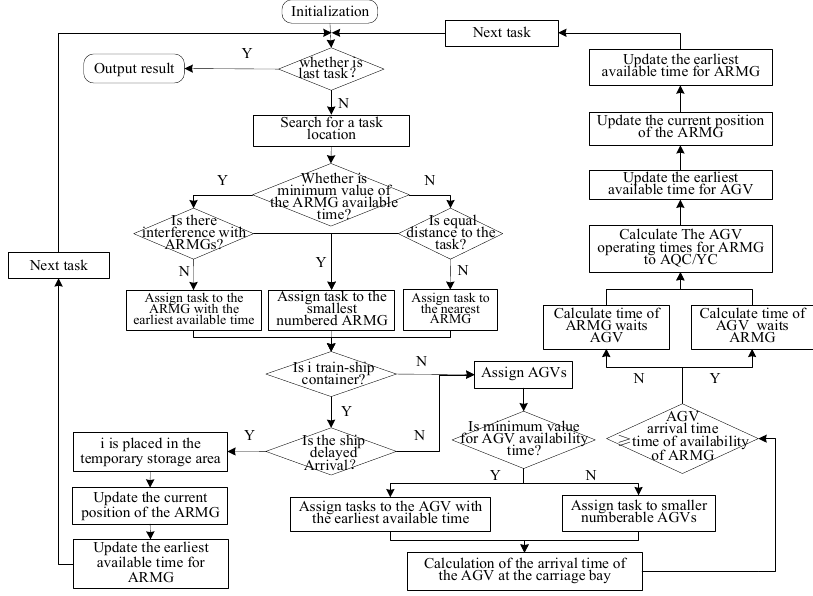
Figure 6. Flow chart of ARMG and AGV task allocation.